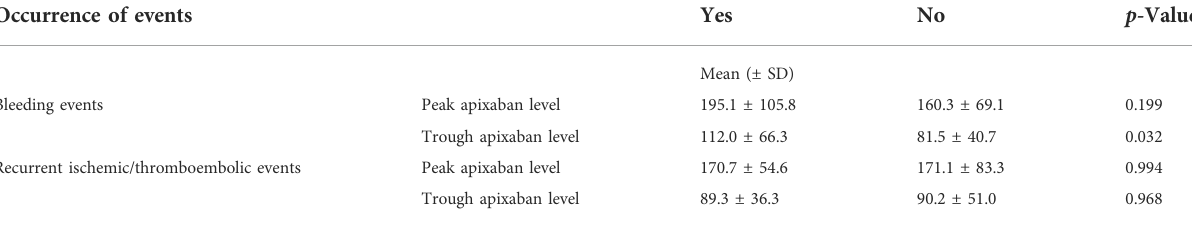
TABLE 4 Mean peak and trough apixaban level in patients with or without bleeding events and recurrent ischemic/thromboembolic events. Occurrence of events